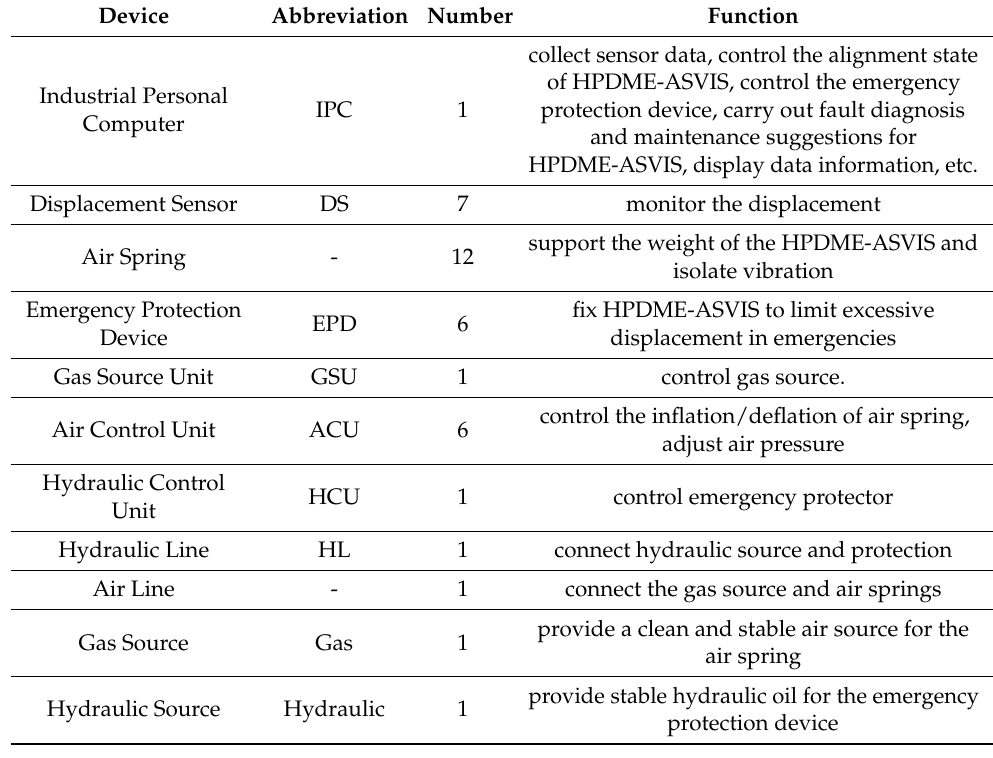
Table 2. The compositions table of HPDME-ASVIS.